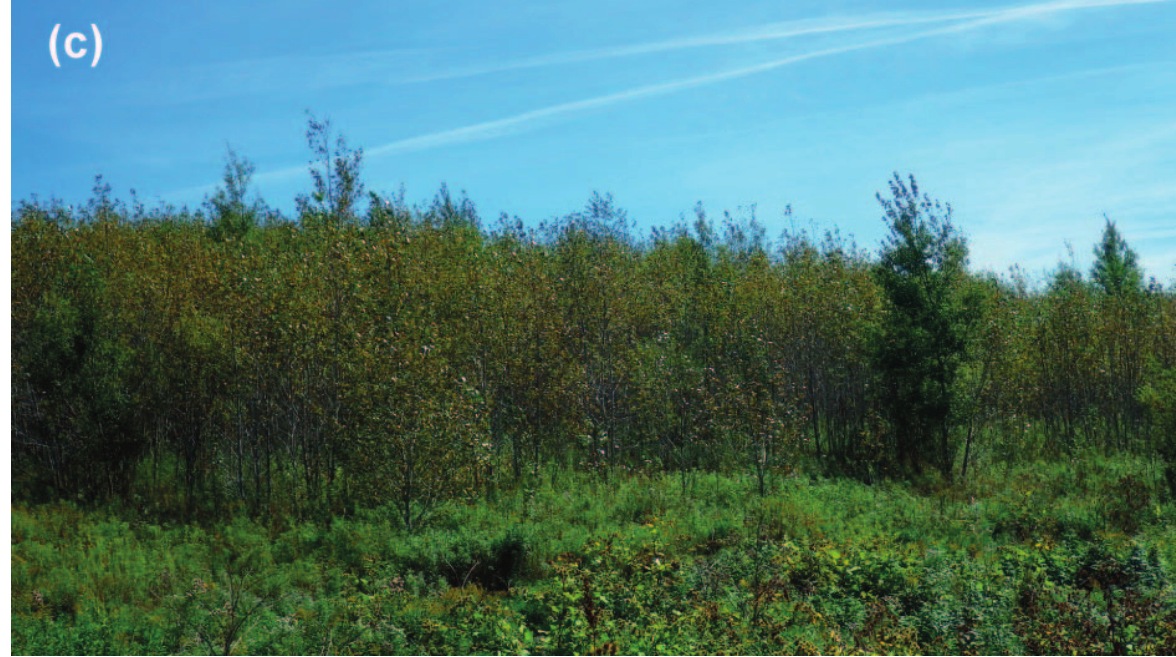
Figure 2. Examples of fallow lands. ( a ) Fallow-1; ( b ) fallow-2; ( c ) forested fallow beyond fallow-2 (dominated by balsam poplar ( Populus balsamifera )) for at least 20 years. See the text for detailed